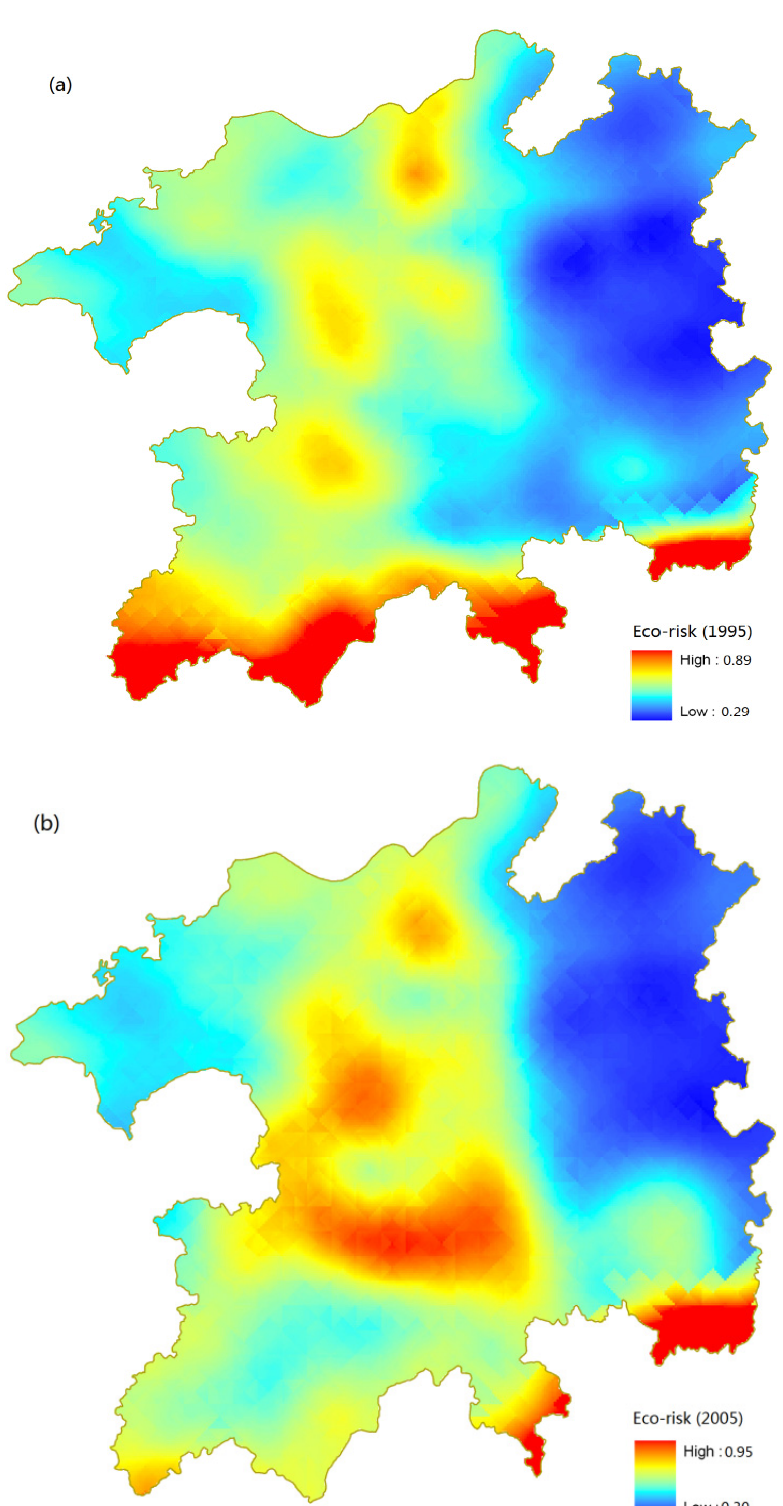
Figure 8. Kriging map of land use eco-risk of Poyang Lake Eco-economic Zone in 1995 and